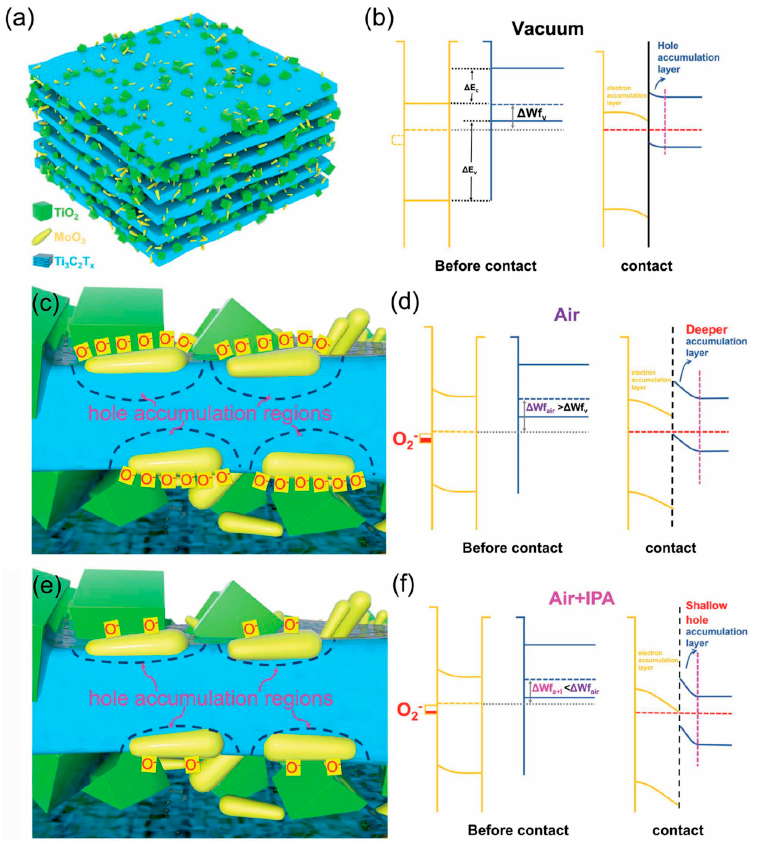
Figure 29. ( a ) Cartoon illustration of the MoO 3 /TiO 2 /Ti 3 C 2 T x sensing layer units, ( b ) the energy band depiction of the situation before and after contact between MXene and MoO 3 in the case of the flat band situation, ( c ) cartoon illustration of the effect of heterojunction formation on the MXene plates, in air, ( d ) the energy band depiction of the situation before and after contact between MXene and MoO 3 in air, ( e ) cartoon illustration of the effect of heterojunction formation on the MXene plates, under isopropanol exposure, and ( f ) the energy band depiction of the situation before and after contact between MXene and MoO 3 under isopropanol exposure. Reprinted with permission from [139]. Copyright 2022: The Royal Society of Chemistry.